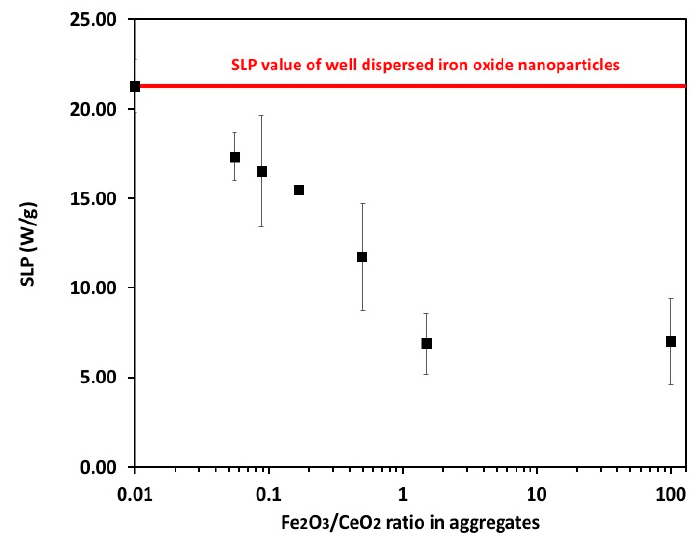
Figure 5. Specific loss power (SLP) versus the ratio between Fe 2 O 3 /CeO 2 ratio. Red line corresponds to the SLP of well dispersed IONPs. Error bars correspond to standard deviation of measurements of at least two samples.